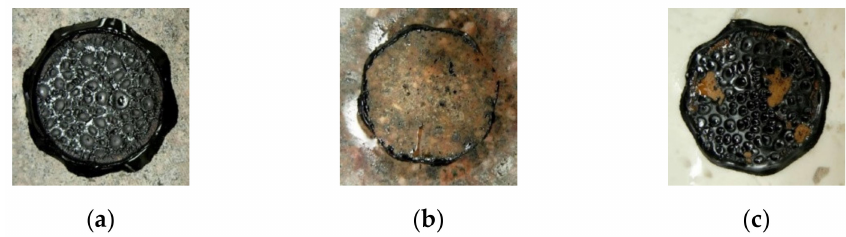
Figure 8. Examples of failure type: ( a ) cohesive; ( b ) adhesive; ( c )